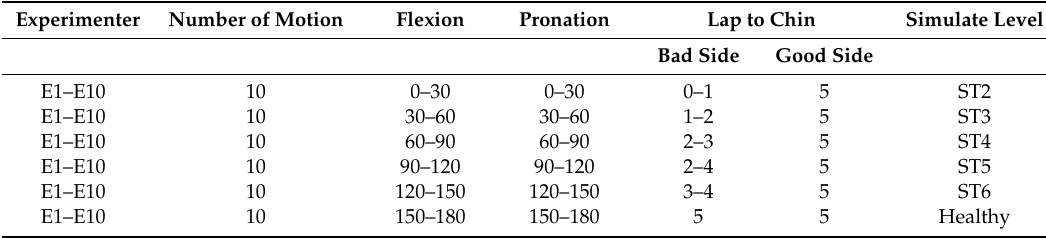
Table 6. Simulation Motions references.